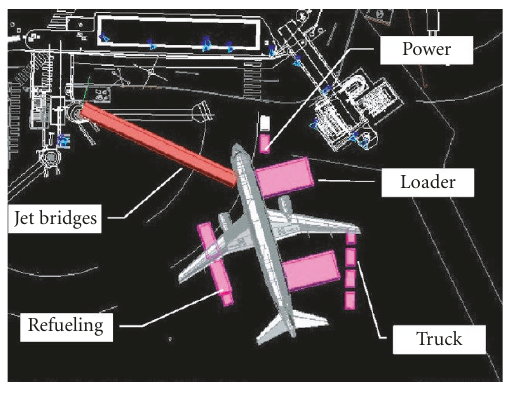
Figure 1: The distribution of equipment around an A320 aircraft on apron echo-40 at Toulouse Airport,